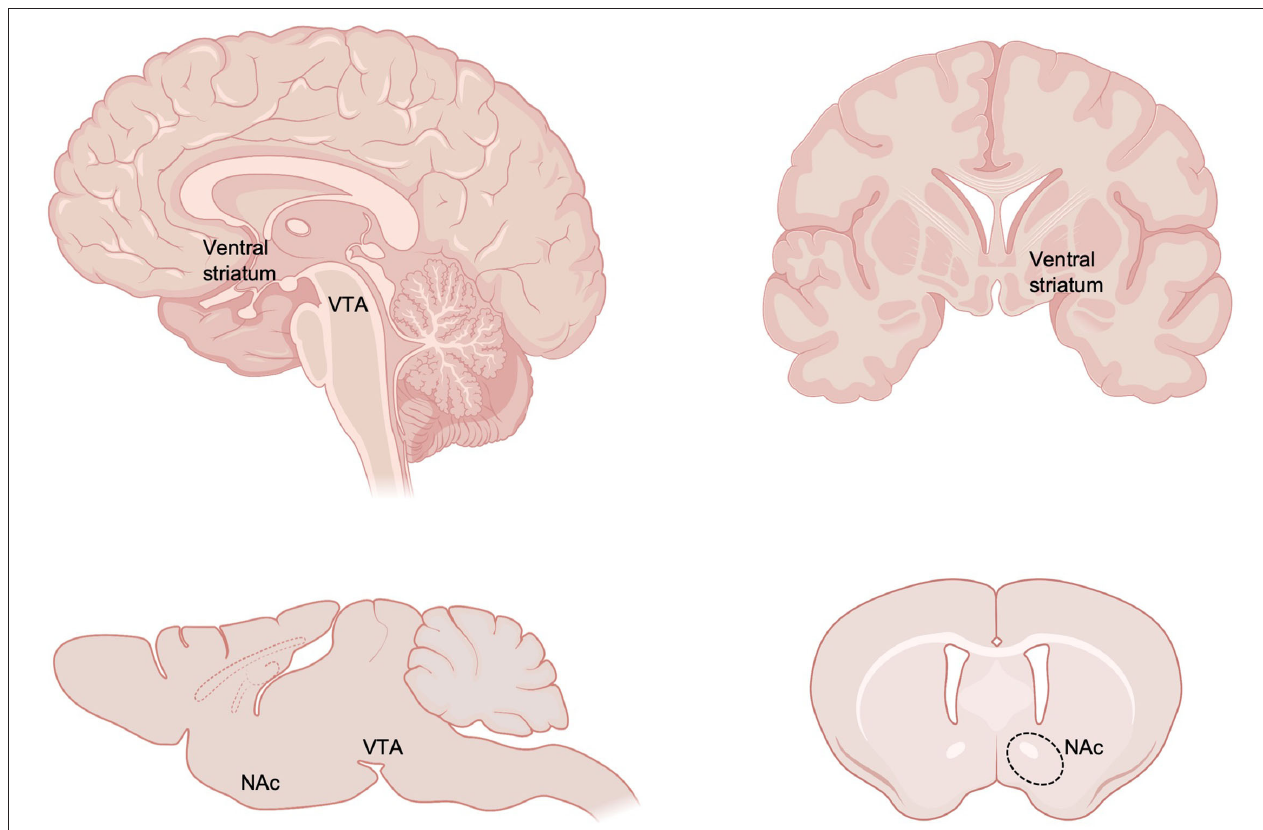
FIGURE 1 | Neuroanatomy of key reward circuitry in humans and rodents. The current review focuses on the impact of early life stress on reward circuitry, with a particular focus on ventral tegmental area (VTA) and nucleus accumbens (NAc), part of the ventral striatum. Created with